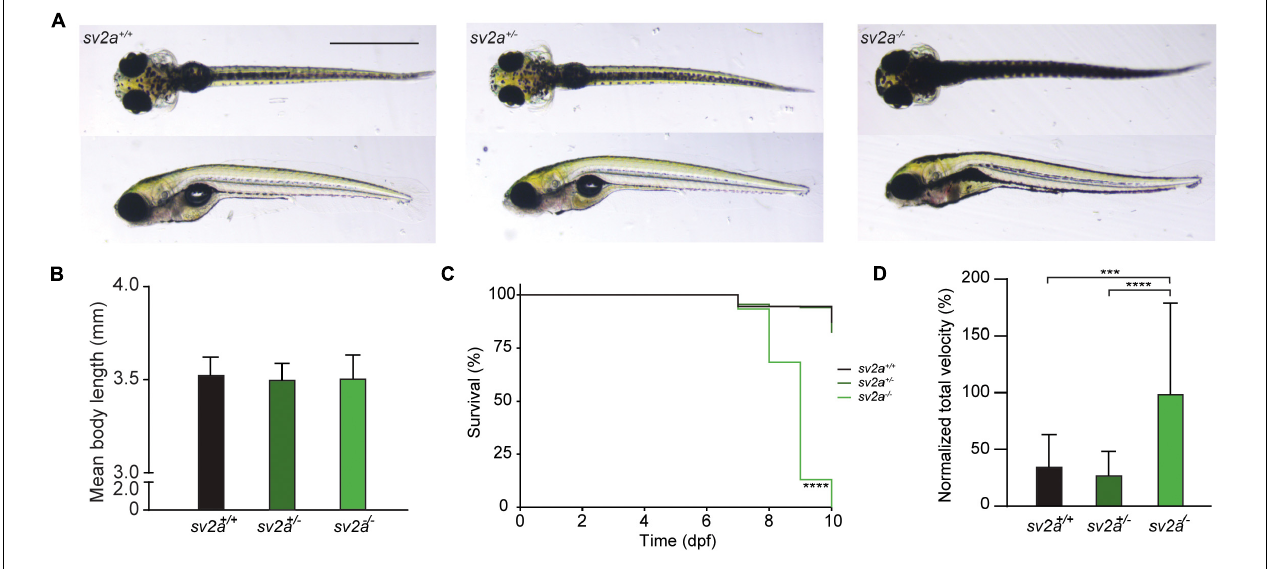
FIGURE 2 | Morphological, survival and behavioral analysis of sv2a knockout zebrafish. (A) Representative images of sv 2a + / + , sv2a + / − , and sv2a − / − zebrafish larvae at 6 dpf. Scale bar 1 mm. (B) Comparison of mean body length of sv2a + / + ( n = 8), sv2a + / − ( n = 8), and sv2a − / − ( n = 8) zebrafish larvae at 6 dpf (mean ± SD). (C) Kaplan-Meier curve demonstrating survival of sv2a + / + ( n = 94), sv2a + / − ( n = 208), and sv2a − / − ( n = 92) zebrafish larvae. Significant larval death in sv2a − / − larvae can be observed in a time-dependent manner. Statistical analysis was performed using Log-rank (Mantel-Cox) test (**** p < 0.0001). (D) Locomotor activity of sv2a + / + ( n = 15), sv2a + / − ( n = 53), and sv2a − / − ( n = 40) zebrafish larvae at 6 dpf. Data were assessed over the total tracking period of 10 min, normalized to sv2a − / − larvae, and expressed as normalized total velocity (%) (mean ± SD). Statistical analysis was performed by one-way ANOVA followed by Dunnett’s multiple comparison (*** p < 0.001, **** p < 0.0001). Data were collected from four independent experiments.